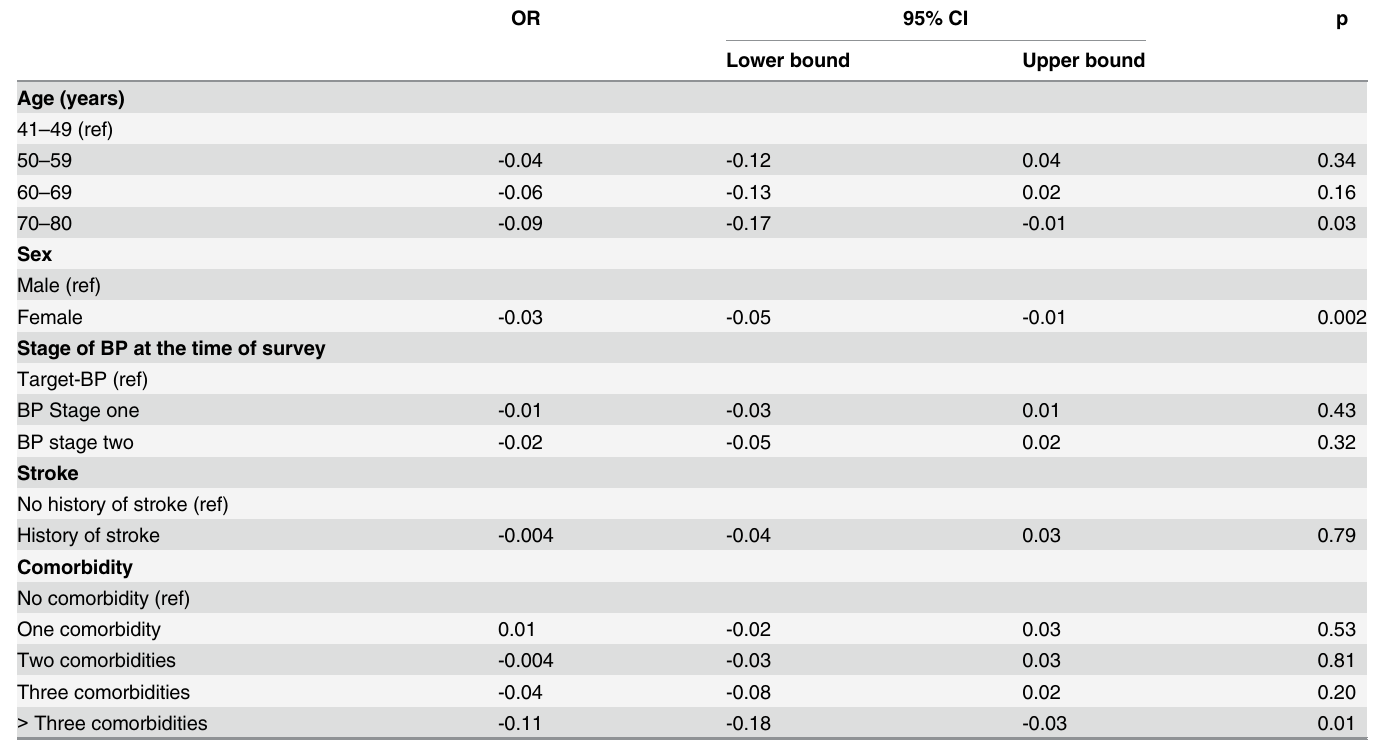
Table 3. Predictors of health-state utilities in hypertensive patients (n =